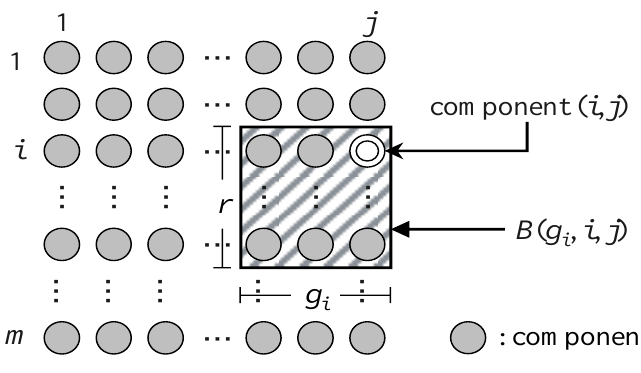
Fig. 2. Illustration